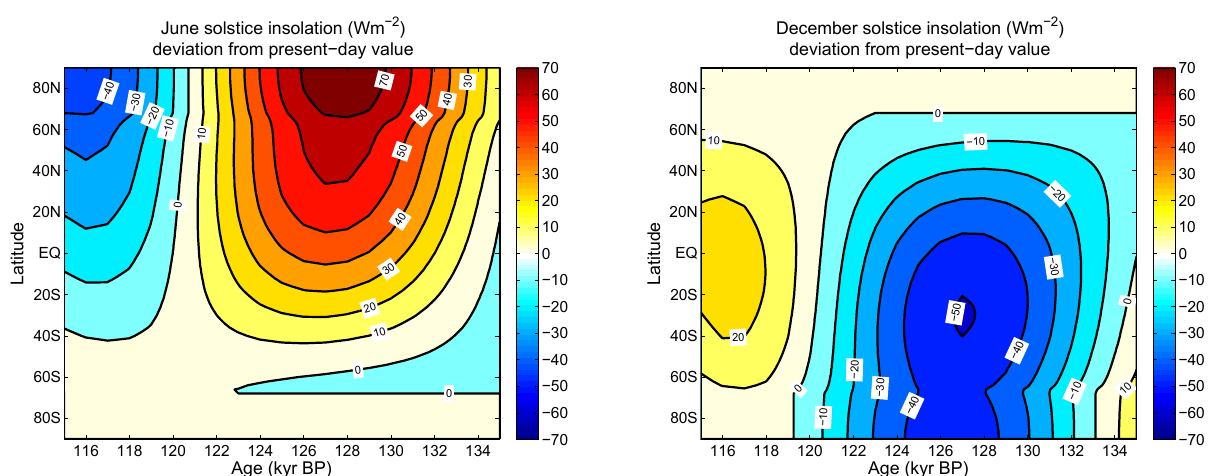
Figure 1. Deviations from the present-day values of the insolation at the boreal summer solstice (left) and at the boreal winter solstice (right) for the LIG (Berger,